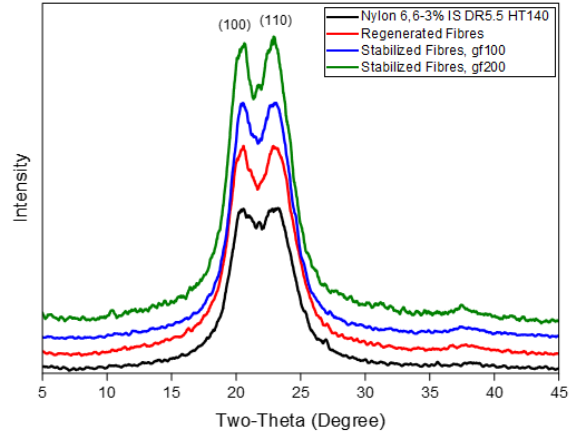
Figure 14. XRD pattern of salt-confined (drawn at, maximum, 5.5 draw ratio and at drawing tem- perature of 140 °C) and reverted nylon 6,6 fibres.